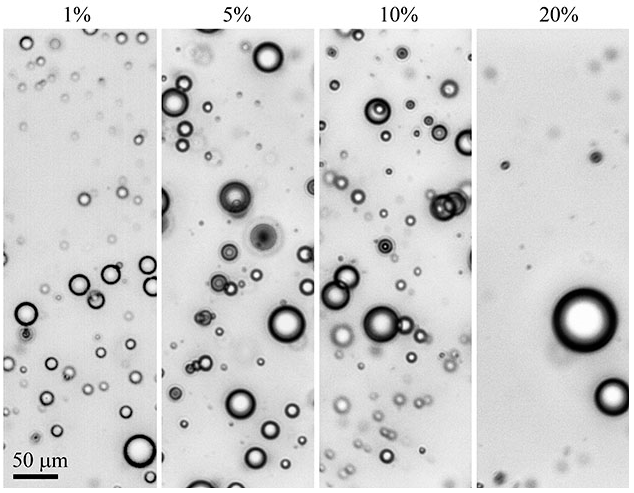
Figure 4. The morphology of a 20% PAN solution containing a different amount of PDMS-5.